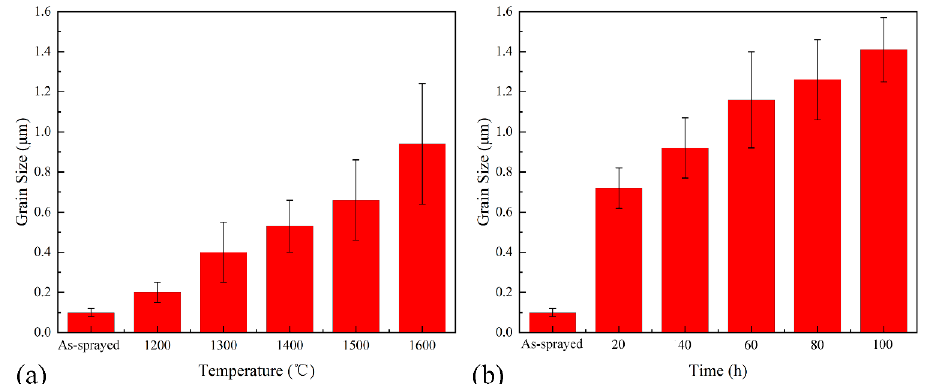
Figure 4. Grain size of the as-sprayed coating and heat-treated coatings: ( a ) samples after heat- treatment for 24 h at different temperatures; ( b ) samples after heat-treatment at 1550 °C for different